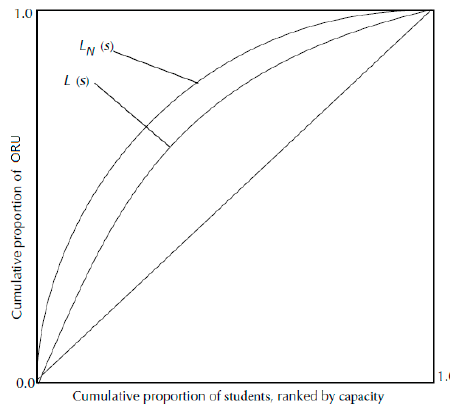
Figure 1. Concentration curves with L N and L as a function of the capacity s ∈ [0,1]. Only s the diagonal line represents the cases where L ( s ) = L N ( s ).